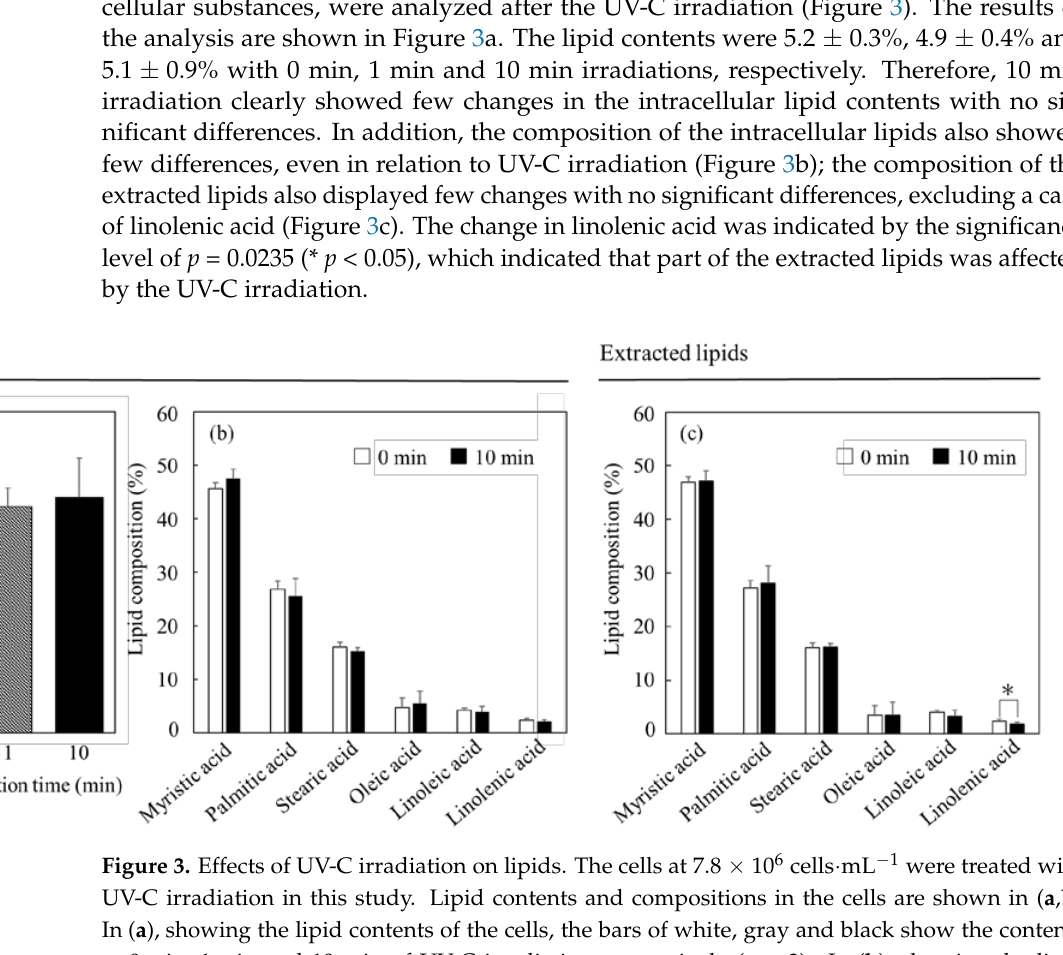
ation could trigger the cell burst through evaluation of decreasing cell densities (Figure